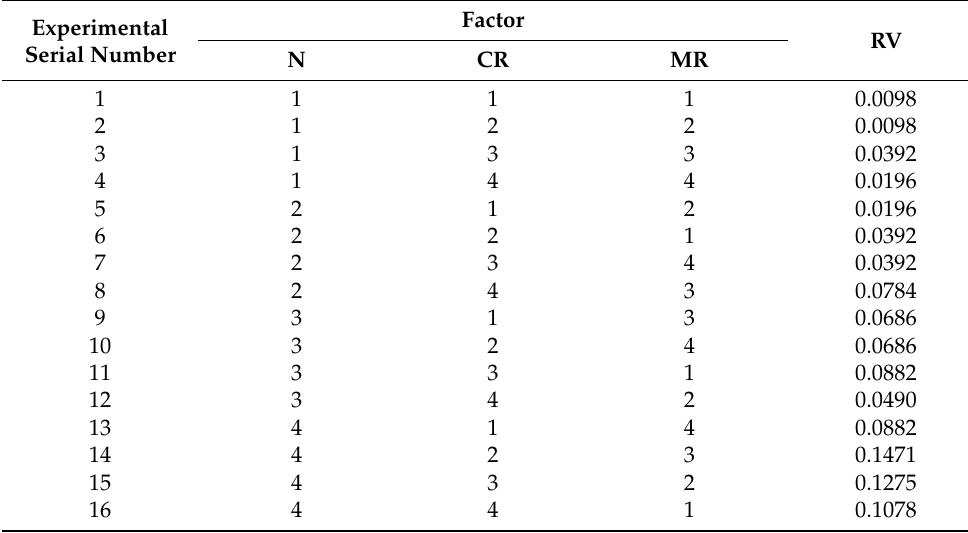
Table 2. Orthogonal table and response eigenvalues.